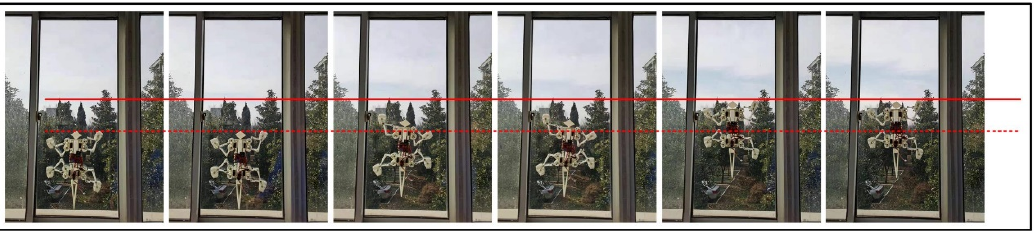
Figure 13. Experiment of the locomotion of the bionic robot climbing on the glass surface in cycle.